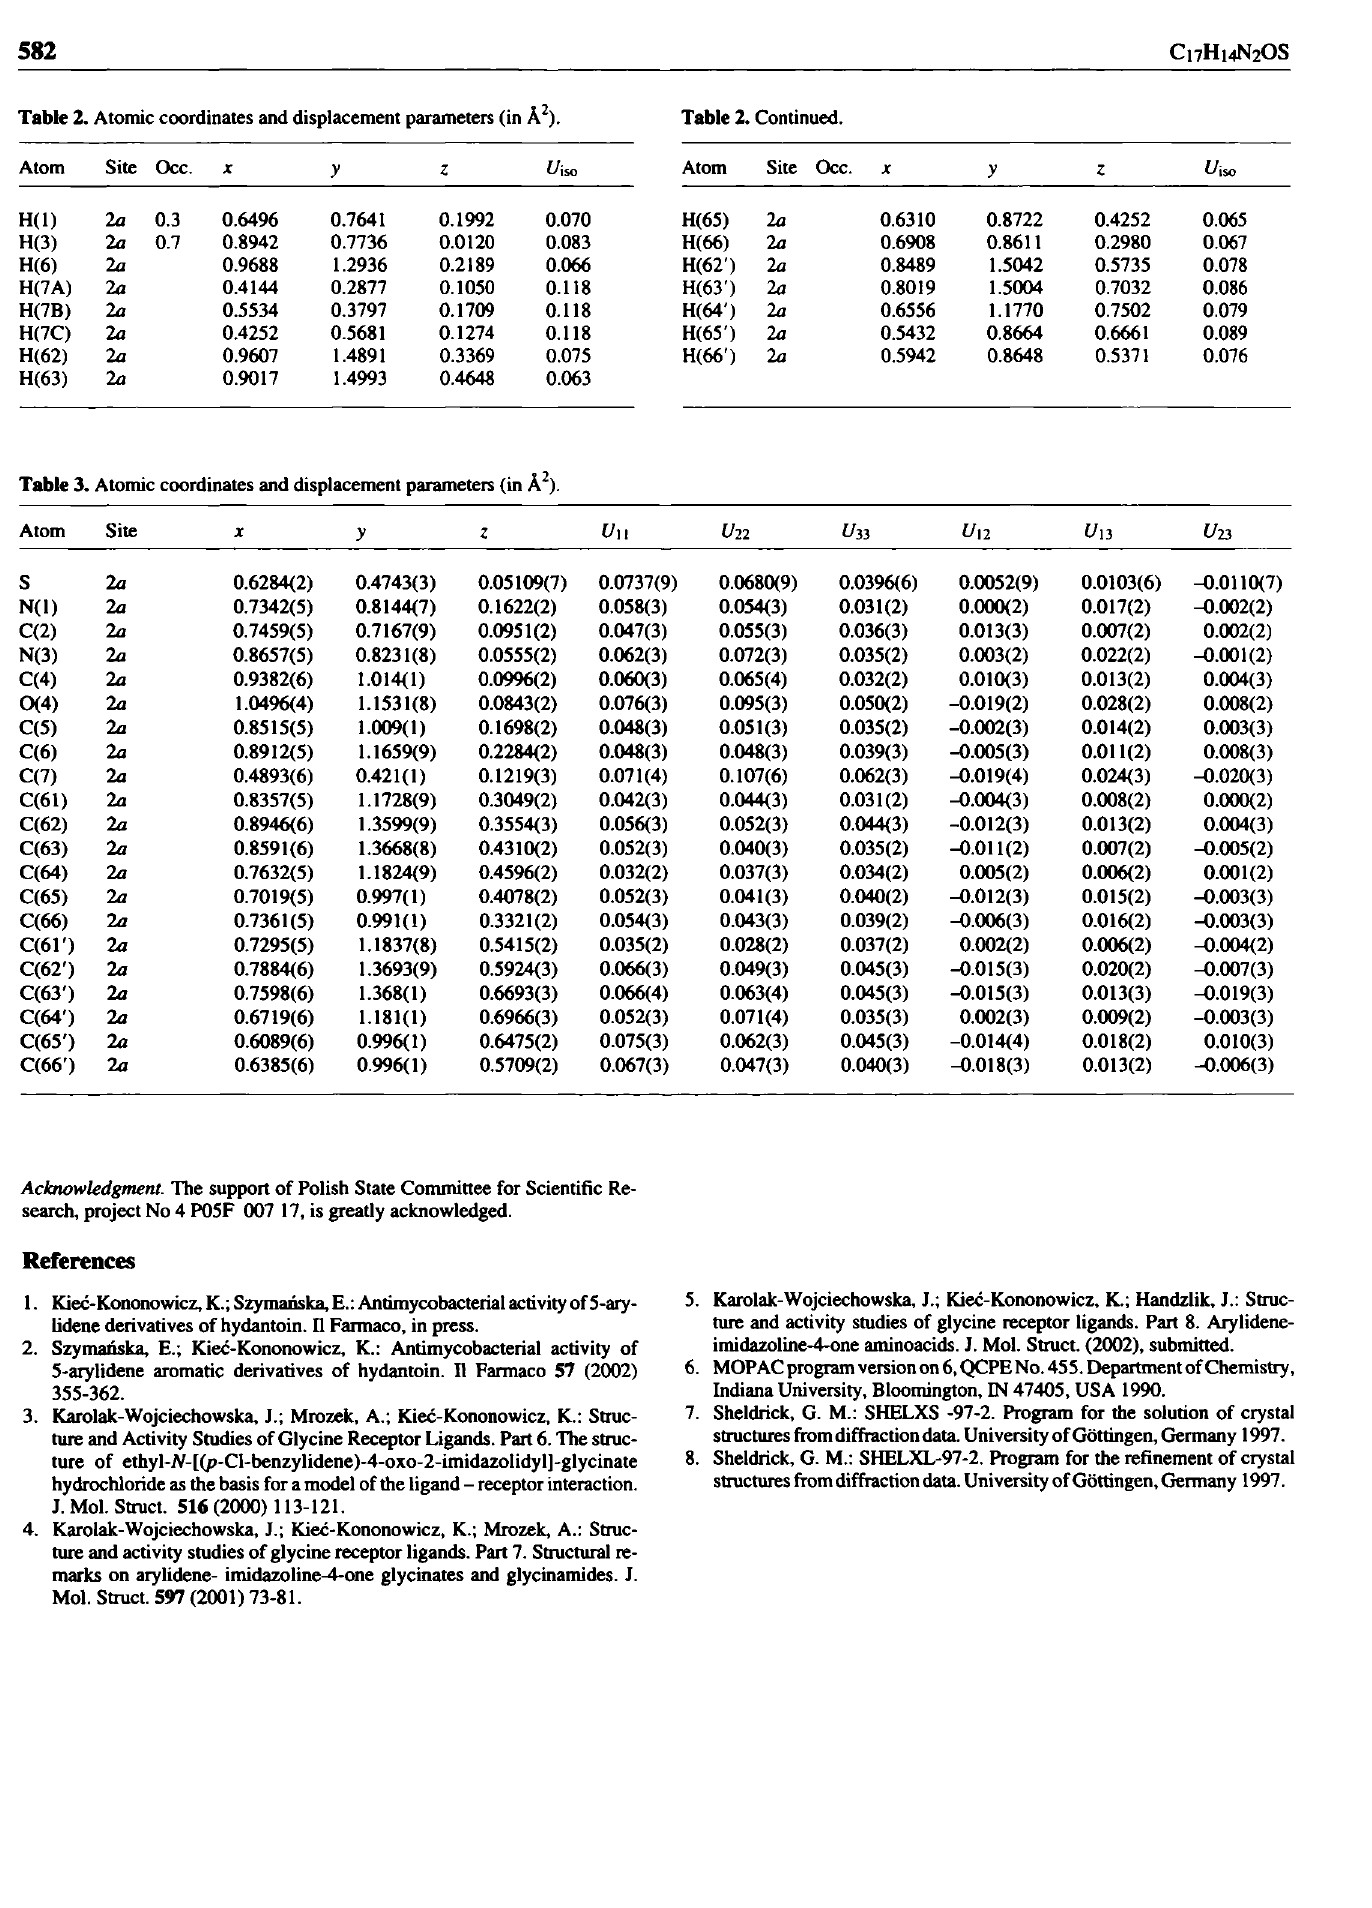
Table 2. Atomic coordinates and displacement parameters (in Â 2 ).